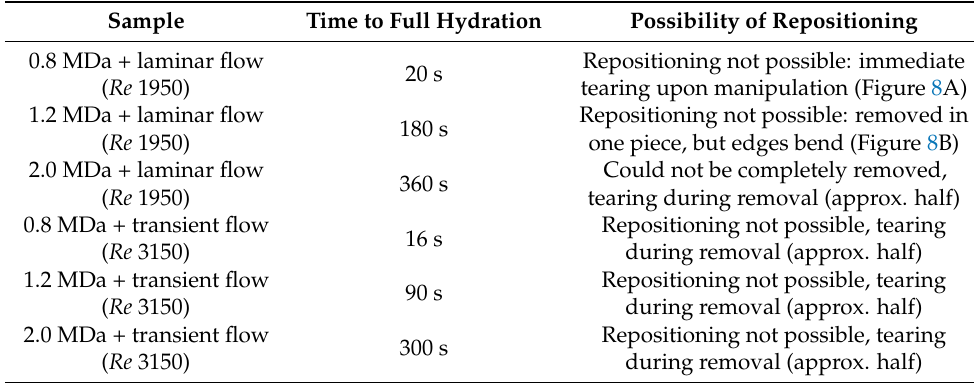
Table 4. Results of application tests on a simulated wound